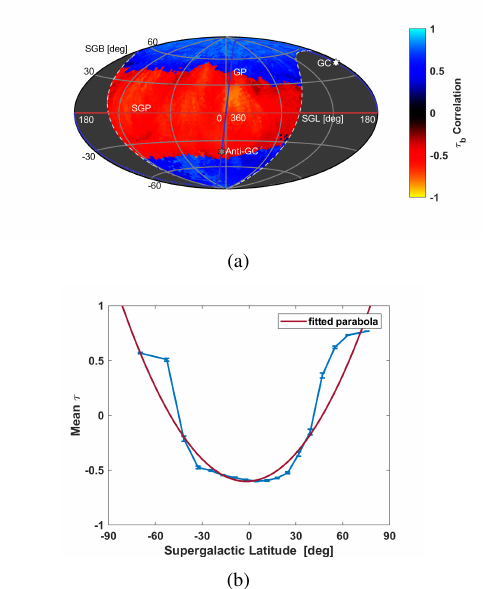
Figure 4. Supergalactic magnetic sheet simulation. (a) Projec- tion of the correlation strength τ b for all grid points. Solid curves indicate the galactic plane (GP) in blue and supergalactic plane (SGP) in red. (b) Mean τ b inside equal solid angle bins for the supergalactic magnetic sheet simulation. The parabola shows the curvature parameter, a , chosen as the test statistic. a = 2 . 5 × 10 − 4 .